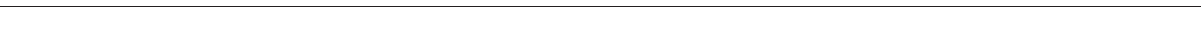
Fig. 3 Characterization of the enhancer landscape during mesendoderm speci fi cation. a Distribution of H3K27Ac identi fi es TEs and SEs in ESC, Eo − and Eo + . Sox2 SE and Id3 SE are indicated as representative SEs b H3K27Ac signal (normalized by length) at constituent enhancers within TEs and SEs. Box plot whiskers show median value and 10 – 90 percentiles. p values were calculated using a one-way ANOVA test. (**** P < 0.0001). c Length (Kb) of active TE and SE regions in ESC, Eo − and Eo + . Median value and 10 – 90 percentiles are represented. p values were calculated using a two-tailed t test. (**** P < 0.0001). d Heatmap showing active (blue) and inactive (white) TEs across ESC, Eo − and Eo + . GO terms linked to biological processes of PCGs associated to TEs shared in all three conditions and TEs uniquely active in Eo + are shown. Examples PCGs are shown to the right. e Heatmap showing active (dark red) and inactive (white) SEs across ESC, Eo − and Eo + . GO terms linked to biological processes of PCGs associated to SEs uniquely active in ESC are shown. Examples PCGs in this cluster are shown to the right. The PCGs associated to the six SEs uniquely active Eo + are shown. f Percentages of uniquely active TEs and SEs in ESC, Eo − and Eo + . g Box plot whiskers of PCG expression (FPKM) of genes proximal to inactive TEs, active TEs and active SEs in ESC, Eo − and Eo + . Box plot whiskers show median value and 10 – 90 percentiles. p values were calculated using a one-way ANOVA test. (**** P < 0.0001). h Schematic of the transition from ESCs to Eo + . Cluster A: PCGs associated to TEs switched-off during the transition. Cluster B: PCGs associated to SEs switched-off during the transition. Cluster C: PCGs associated to TEs switched-on during the transition. Cluster D: PCGs associated to SEs switched- on during the transition. Cluster E: PCGs associated to TEs active during the transition. Box plot whiskers with LogFC of expression between Eo + and ESCs are shown to the right. Median value and 10 – 90 percentiles are represented. p values were calculated using a two-tailed t test. (**** P <